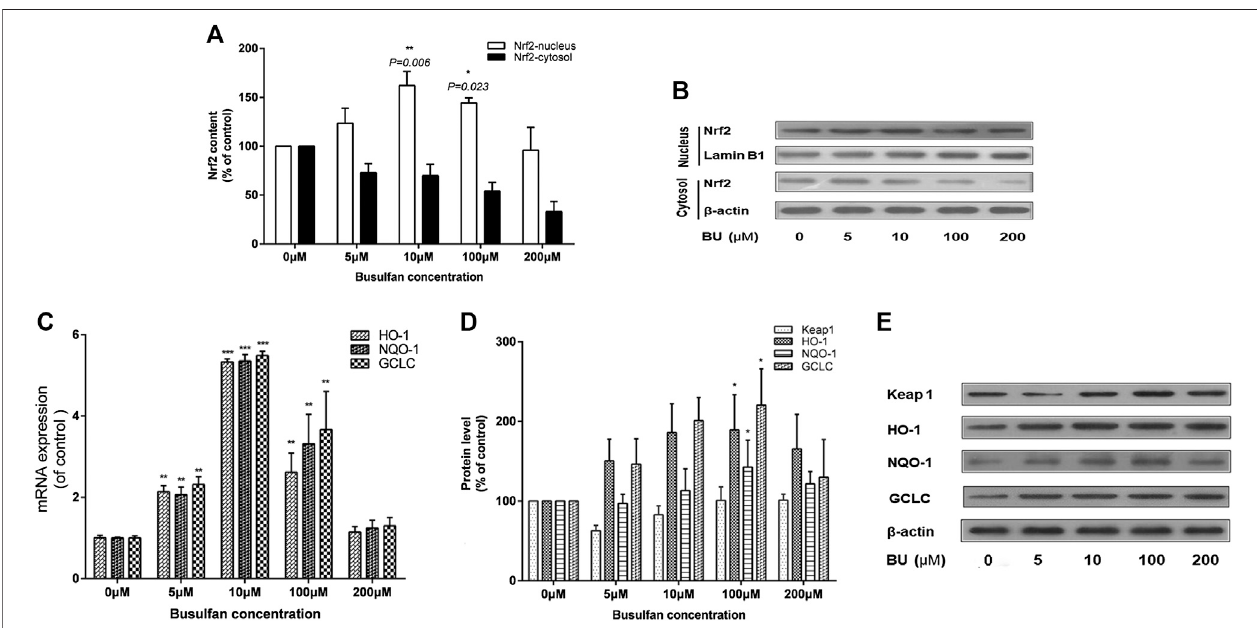
FIGURE5| BU signi fi cantlyactivatedNrf2signalingpathway.Nrf2activationanditsdownstreamproteinslevelsweregraduallyinhibitedastheBUexposureincreased signi fi cantly.Nrf2proteinlevels(westernblotanalysis: A,B) ,HO-1,NQO-1,andGCLCmRNAlevels(realtimePCRanalysis: C) andtheirproteinlevels(westernblotanalysis: D) in EA. hy 926 cells exposed to the increasing BU concentrations. * represents p < 0.05; ** represents p < 0.01; *** represents p < 0.001; μ M represents μ